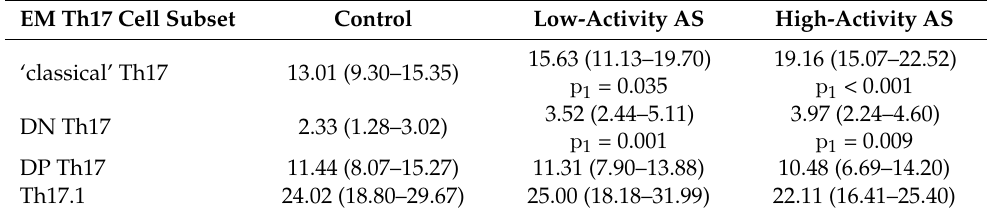
Table 6. Peripheral blood EM Th17 cell subset composition (%) in activity-driven AS patients ( Ме (C 25 –C 75 )).